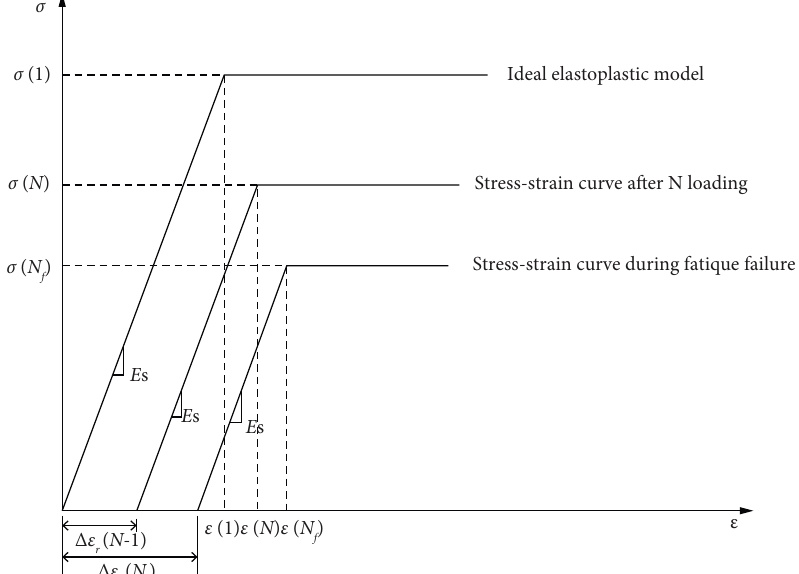
Figure 10: Constitutive model of reinforcement under fatigue load damage.